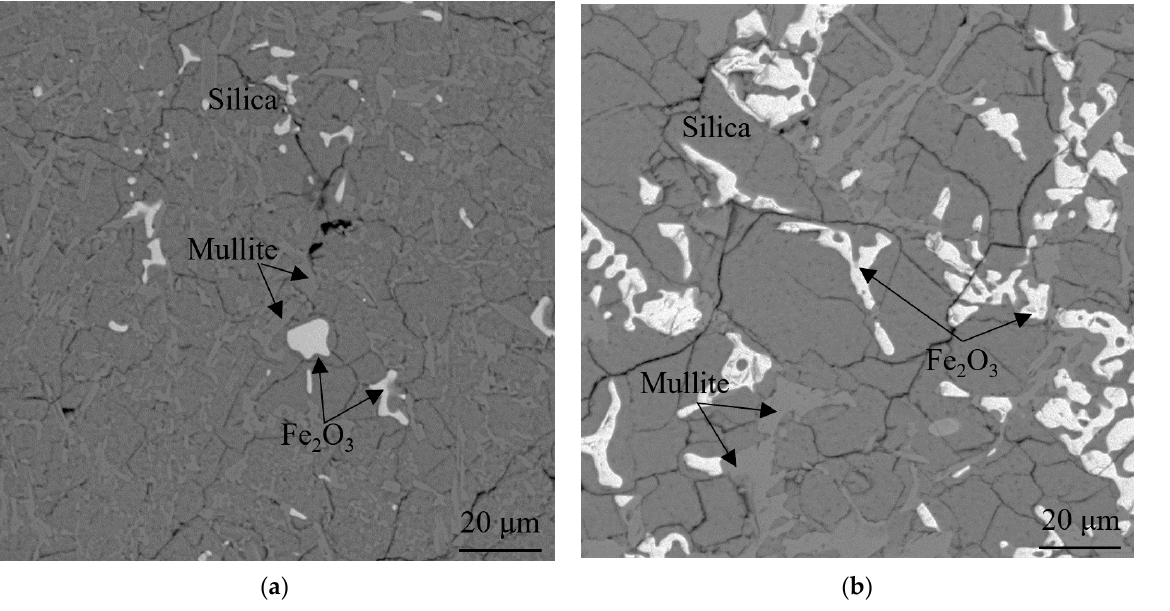
Figure 5. SEM micrographs for the equilibrium phases of samples B5 and B6 at 1300 °C in air. ( a ) B5 at 1300 °C; ( b ) B6 at 1300 °C. Table 2. Equilibrium compositions for samples B5 and B6 at 1300 °C in air.